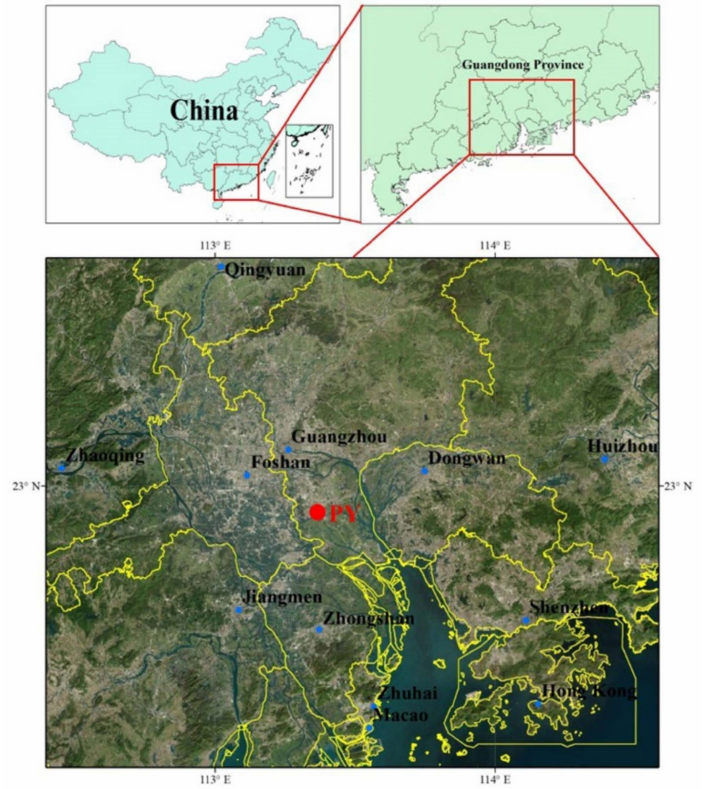
Figure 1. Location of VOC monitoring sites in the Pearl River Delta